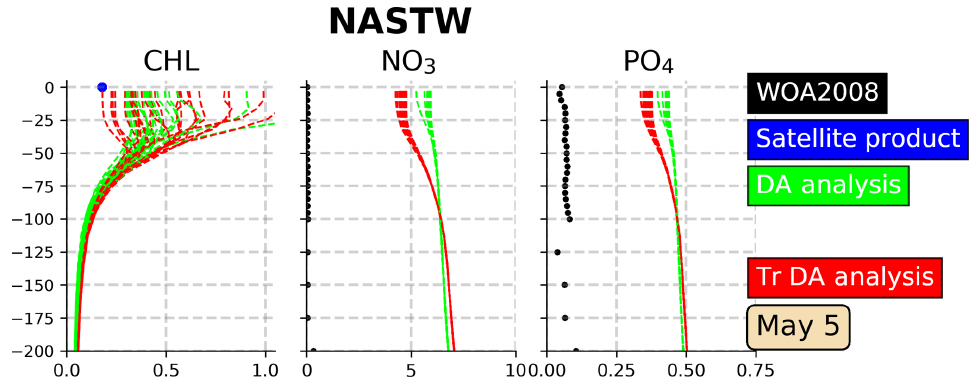
Figure 9. Vertical profiles (0–200m) of Chl a (mgChlm − 3 ), nitrate (mmolNm − 3 ) and phosphate (mmolPm − 3 ) in the province NASTW (35 ◦ N, 60 ◦ W) for 5 May 2005. The 24-member analysis (in green) and the 24-member transformed analysis (in red) ensembles are rep- resented. Black dots correspond to monthly mean nitrate and phosphate concentrations extracted from WOA2018 database. The blue dot corresponds to daily mean surface Chl a obtained from the Global Ocean Satellite